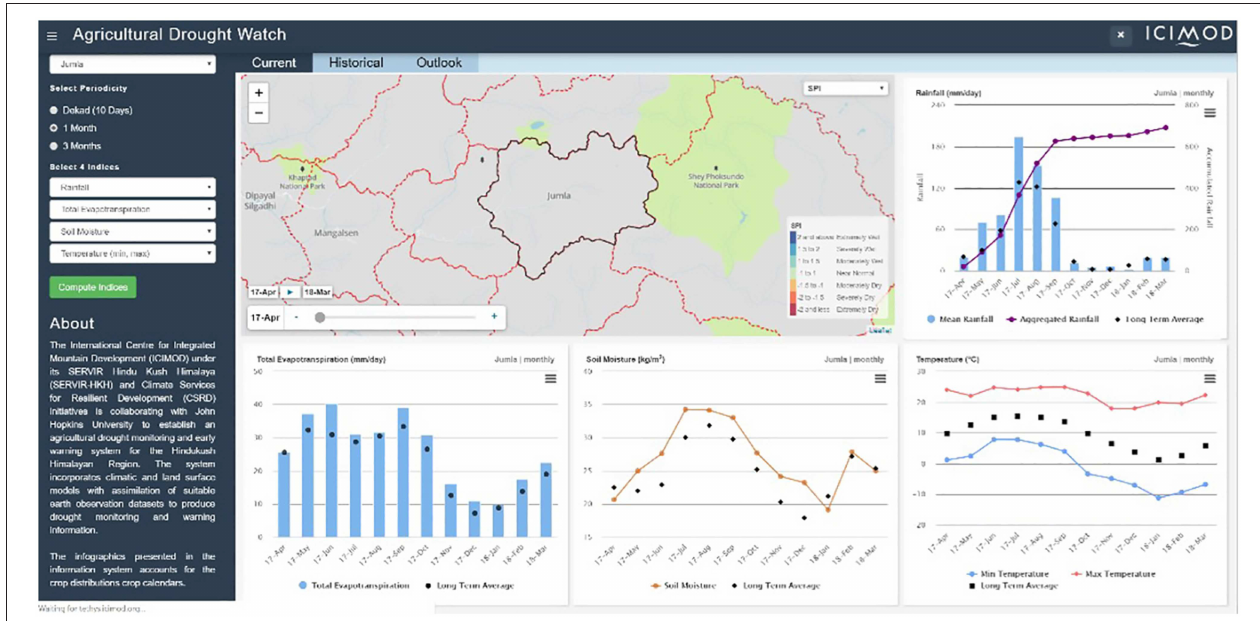
FIGURE 10 | The SERVIR-HKH agricultural drought watch Tethys